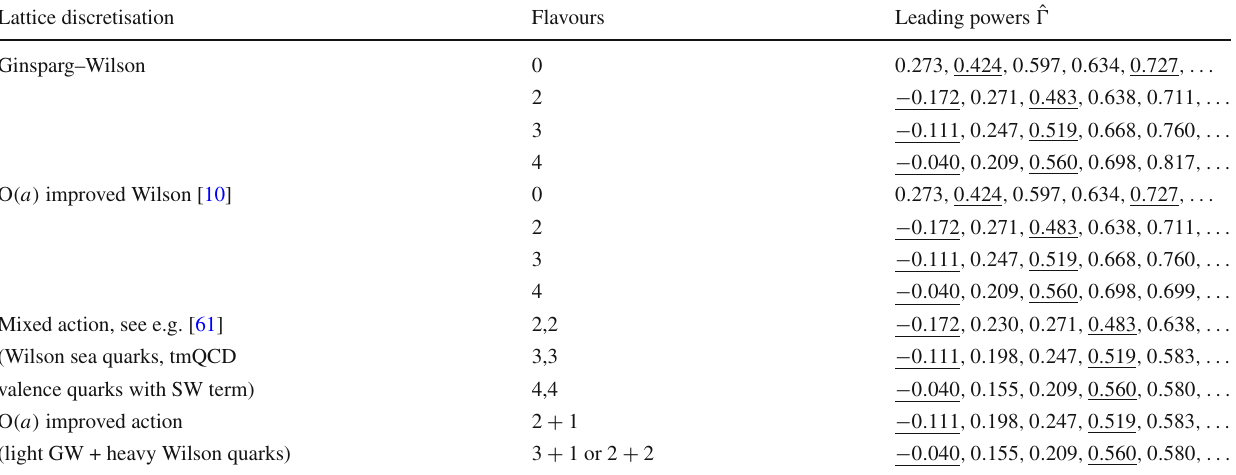
Table 1 Non-exhaustive examples for leading powers in the coupling belong to massive operators. If the Lüscher–Weisz action [28] is being ˆ (cid:2) used rather than the more general case in Eq. (73) the leading powers relevant for the leading order lattice artifacts a 2 [¯ g 2 ( 1 / a ) ] at N = 3 do not change, since the operator affected by this change of matching and various values for N f . Degeneracies are not listed as they cannot be is already sufficiently suppressed by ˆ γ i (cid:2) 0 . 86 for 2 ≤ N f ≤ 8. The distinguished numerically. While vanishing matching coefficients have leading powers for O ( a ) improved tmQCD should be identical to been taken into account by shifting the corresponding leading power by 1, hierarchies between the various coefficients are ignored and cer- tainly should be looked at [16]. We limit considerations to commonly used combinations and some interesting cases. For the gauge action we assume use of a variant compatible to Eq. (73). The underlined numbers